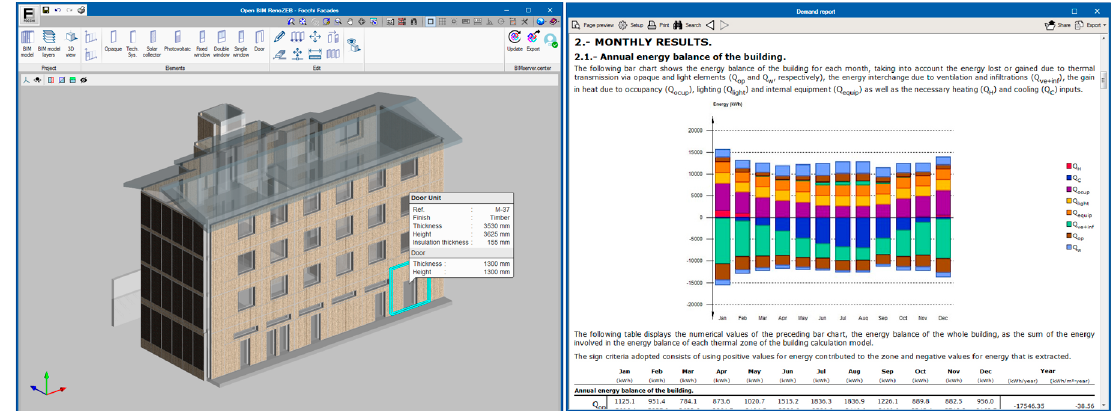
Figure 2. Renovation configurator tool ( left ) and summary of simulation results ( right